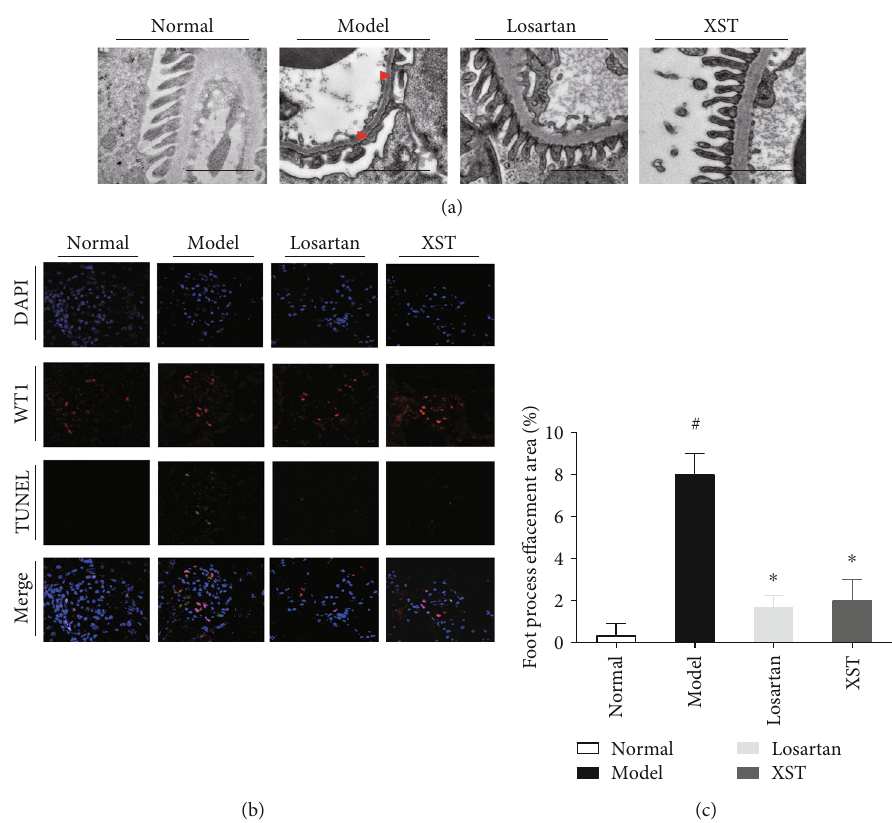
Figure 2: E ff ects of XST on podocyte morphological changes and podocyte apoptosis in diabetic rats. Representative transmission electron photomicrographs (a) and semiquantitative ultrastructural analysis (c) in diabetic rats. Representative immuno fl uorescence labelling including the TUNEL assay, WT1, and DAPI (b) on frozen kidney sections. The cells with WT1 (red), TUNEL (green), and DAPI (blue) were identi fi ed as the positive apoptotic podocytes. Scale bar = 2 μ m . Red arrowheads indicated podocyte foot process e ff acement. Results were expressed as the means ± SEM . # P < 0 : 05 vs. normal; ∗ P < 0 : 05 vs.